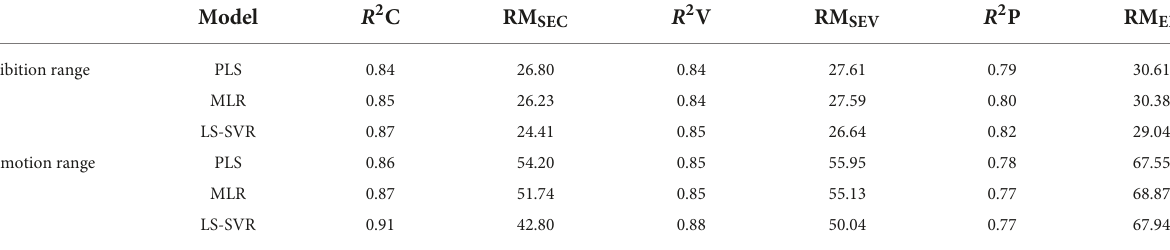
TABLE 2 Statistical variables of training and testing data of inhibition or promotion rate (%) in the PLS, MLR, LS-SVR